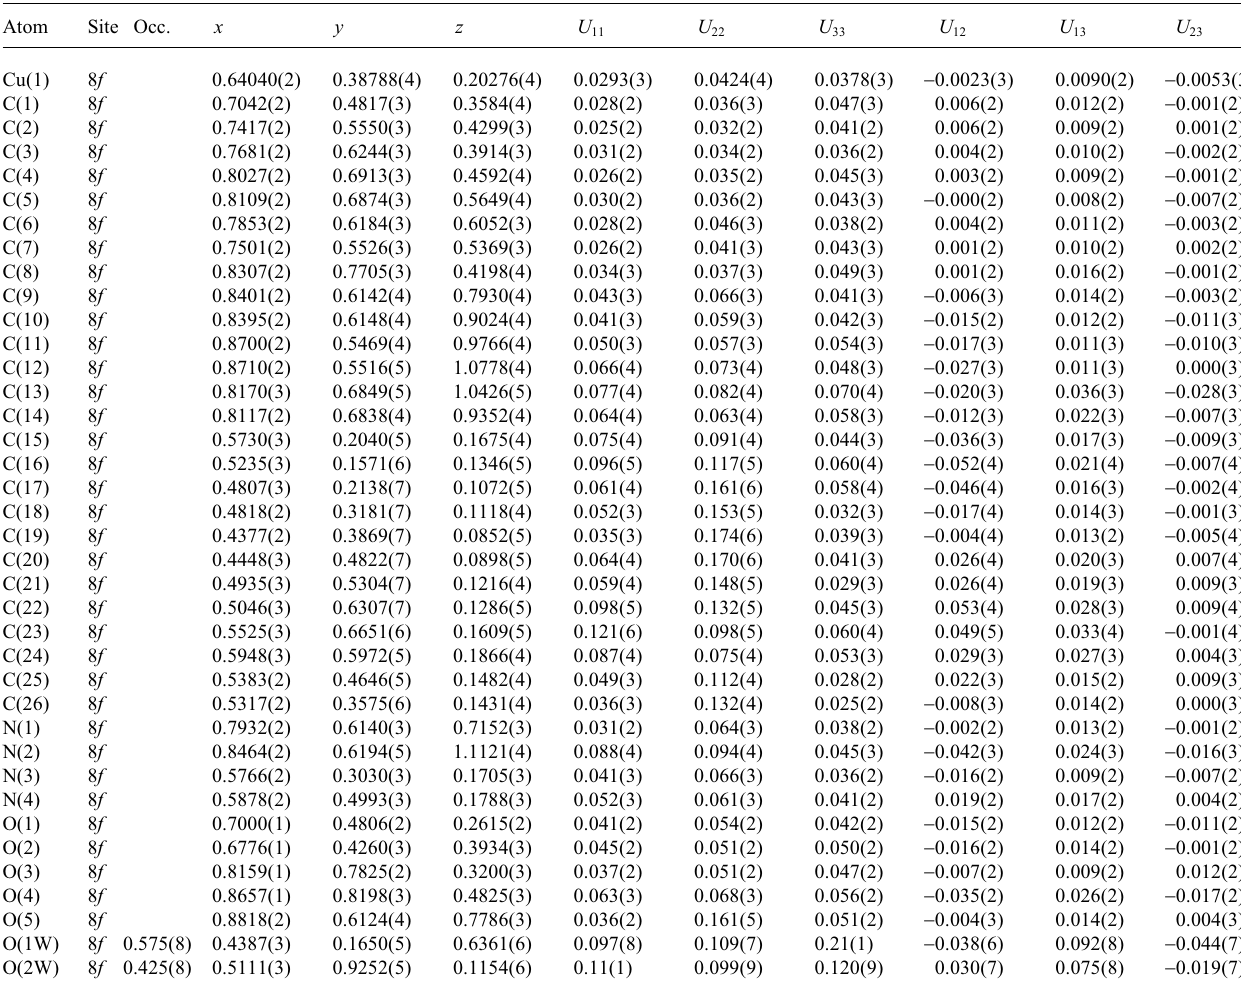
Table 3. Atomic coordinates and displacement parameters (in Å 2